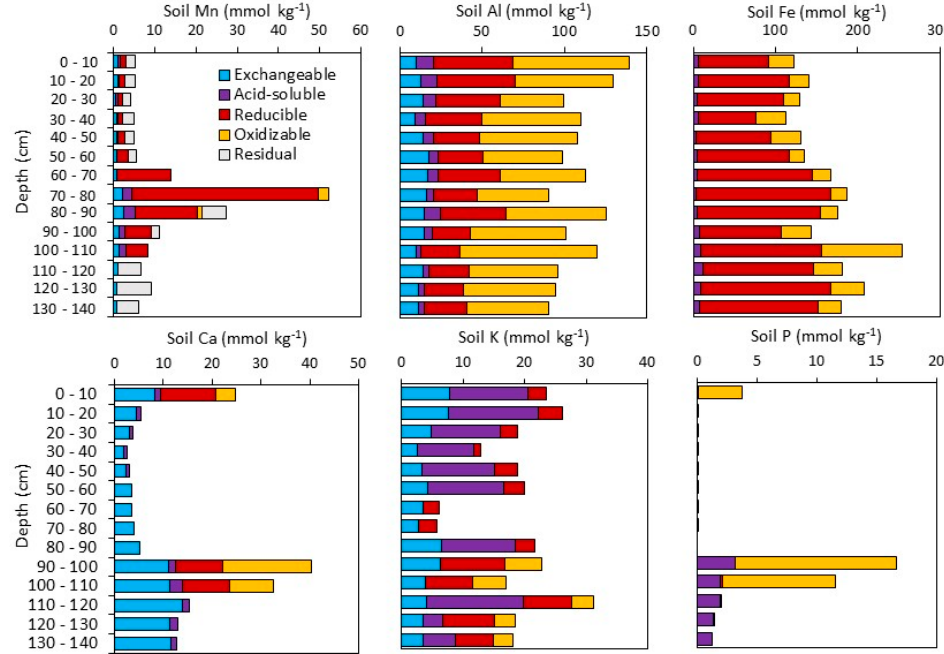
Figure 3. Element concentrations (mmol kg − 1 ) in sequentially extracted exchangeable, acid-soluble, reducible, oxidizable, and residual soils fractions. Residual K, Al, and Fe concentrations are not shown. Error bars are omitted for clarity.